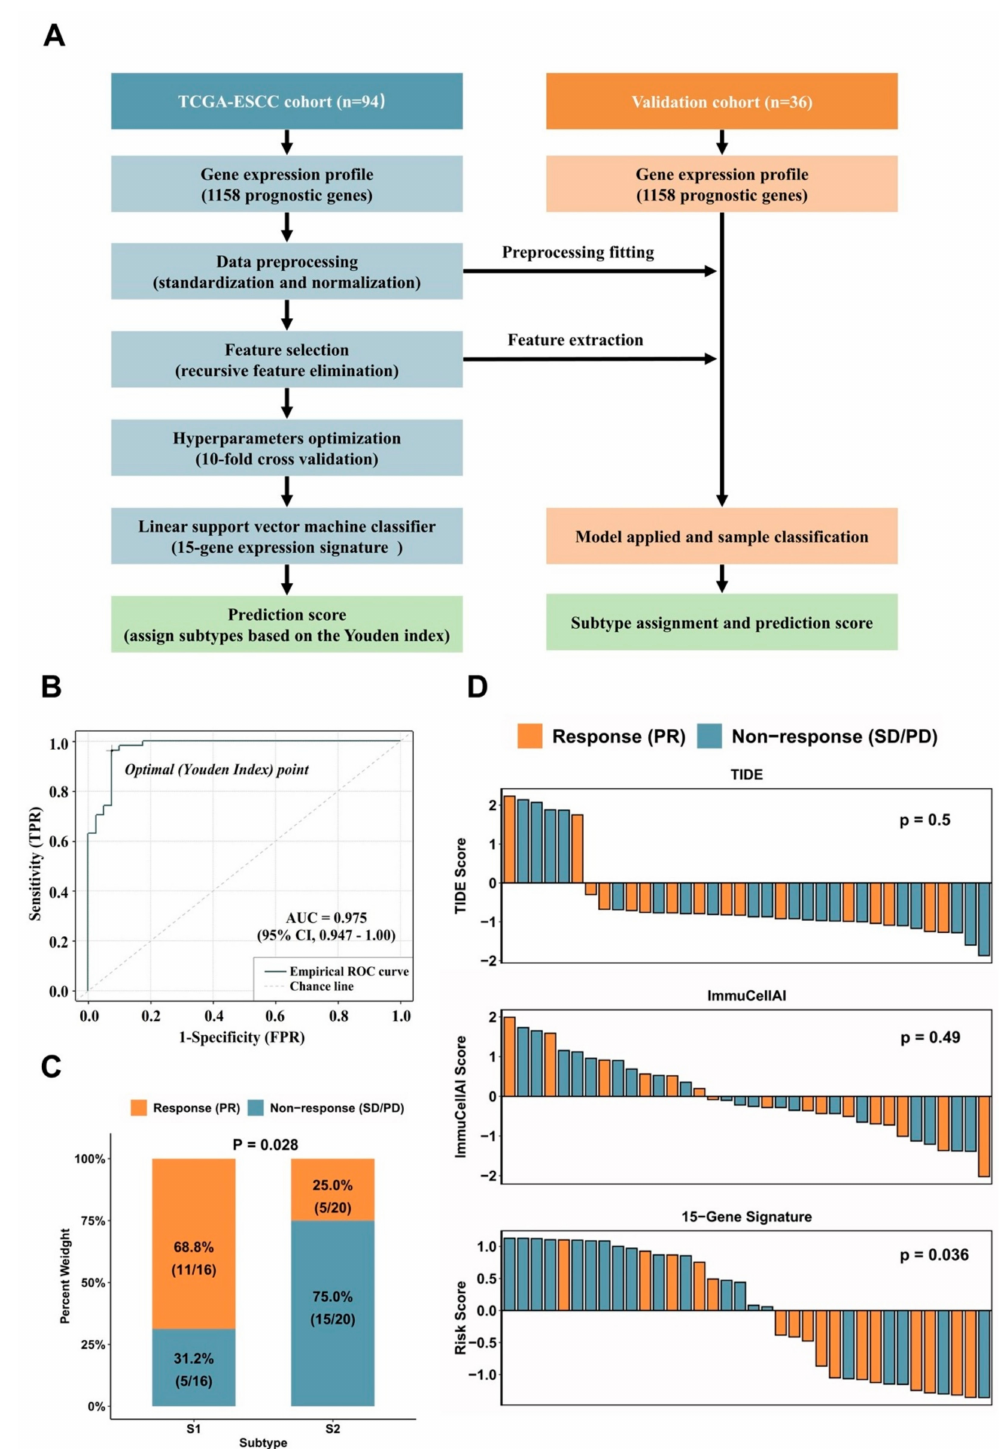
Figure 4. Identification and validation of a 15-gene expression signature. ( A ) Flow chart of the 15-gene expression signature identification. ( B ) The ROC curve of the 15-gene expression signature in the validation set. ( C ) Response rates between S1 and S2 subtypes. ( D ) Waterfall plots of prediction scores of TIDE, ImmuCellAI and 15-gene expression signature across 36 ESCC patients treated with ICIs. ROC, receiver operating characteristic; AUC, area under the curve; ESCC, esophagus squamous cell carcinoma; ICIs, immune checkpoint